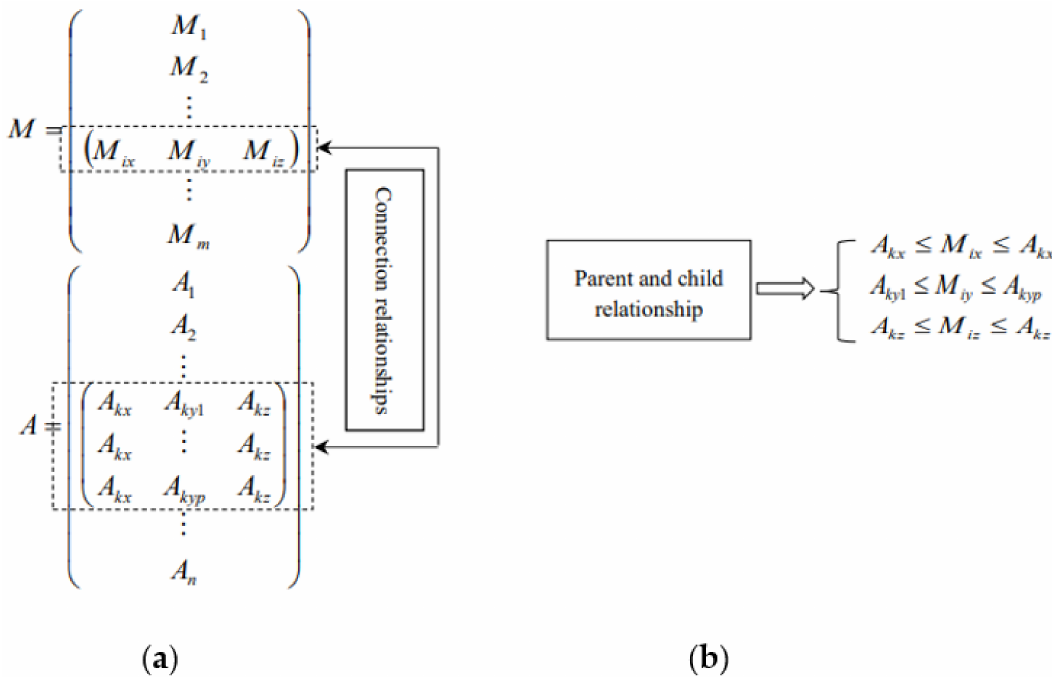
Figure 5. ( a ) The connection relationship between structural component numbered ( i ) and structural component numbered ( k ); ( b ) The parent and child relationship between matrix M i and matrix A k